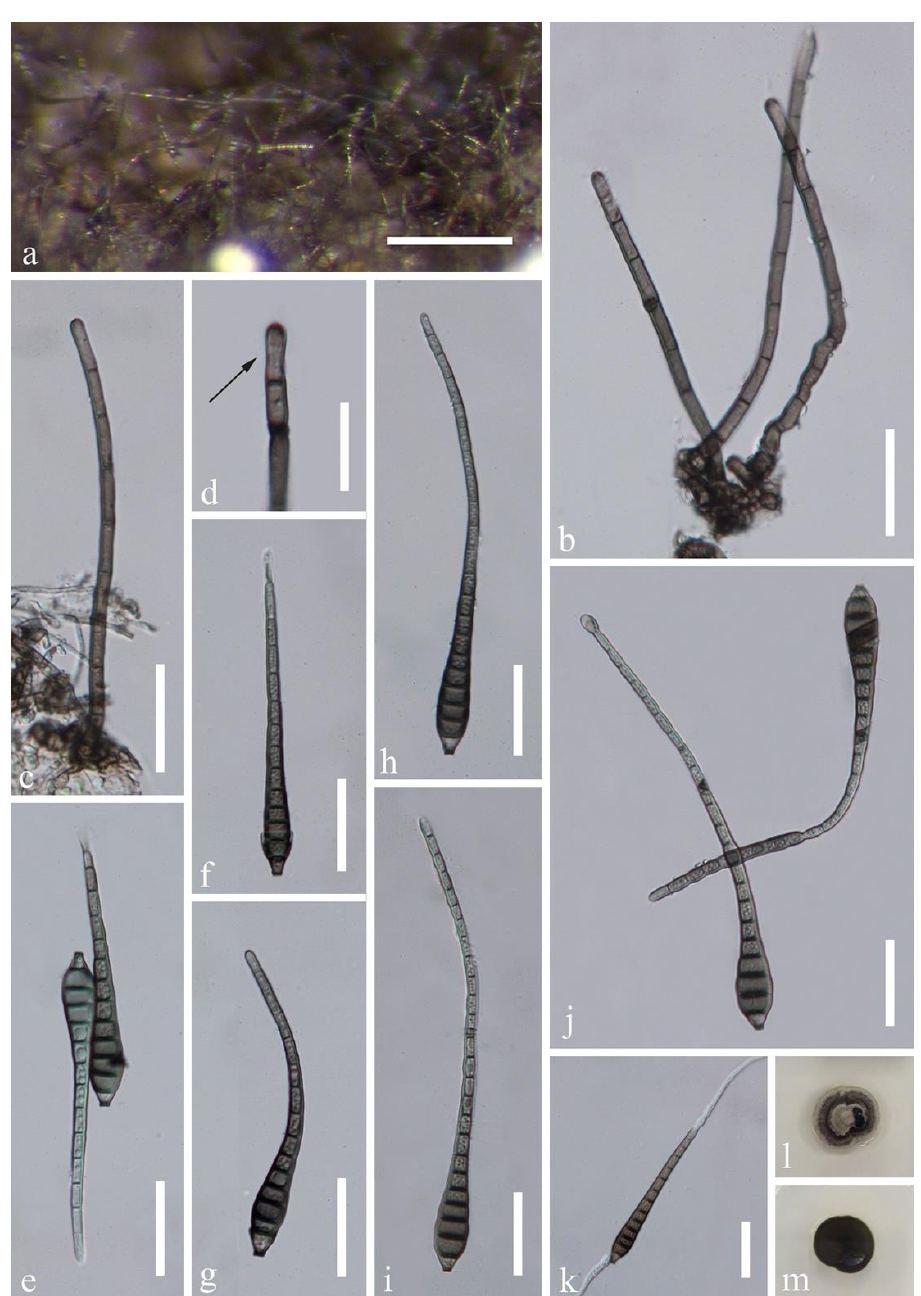
Figure 2. Distoseptispora amniculi (MFLU 21-0138, holotype). ( a ) Colonies on wood. ( b , c ) Conidio- phores. ( d ) Conidiogenous cell. ( e – j ) Conidia. ( k ) Germinated conidium. ( l , m ) Colony on PDA, l from above, m from below. Scale bars: ( a ) 200 µm, ( b , c , e – k ) 30 µm, ( d ) 20 µm. Distoseptispora atroviridis J. Yang and K.D. Hyde, sp. nov., Figure 3. Index Fungorum number: IF558671; Facesoffungi number: FoF10252. Etymology: referring to the dark green conidia. Holotype: HKAS 112616 Saprobic on submerged decaying wood in a freshwater habitat. Asexual morph: Col- onies on wood effuse, dark brown to black, scattered or in small groups, glistening. My- celium mostly immersed, composed of septate, smooth-walled, brown to hyaline hyphae.